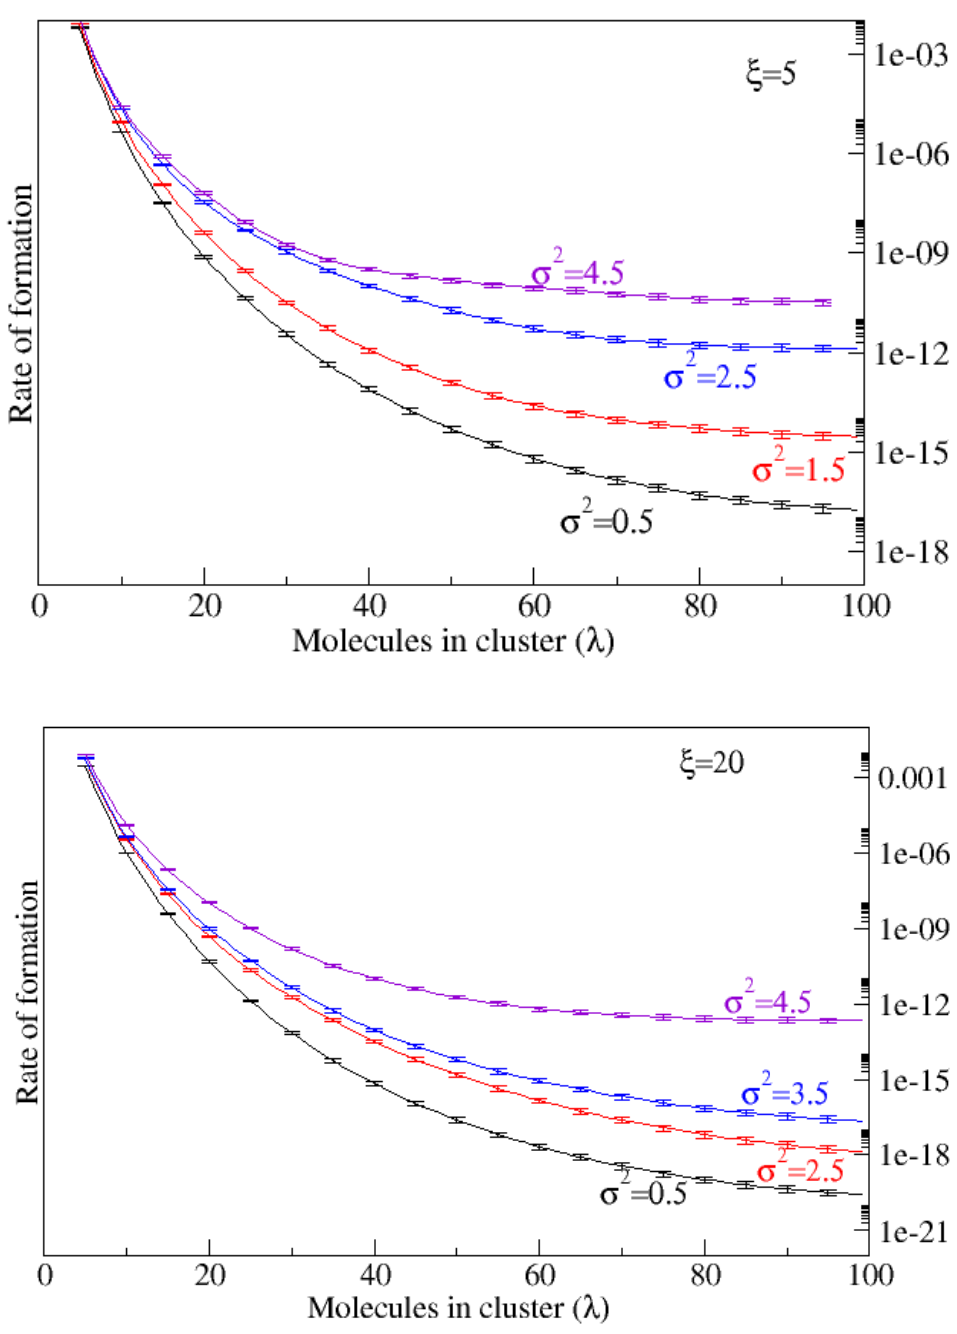
= a 2 / D ) as a function of their 0